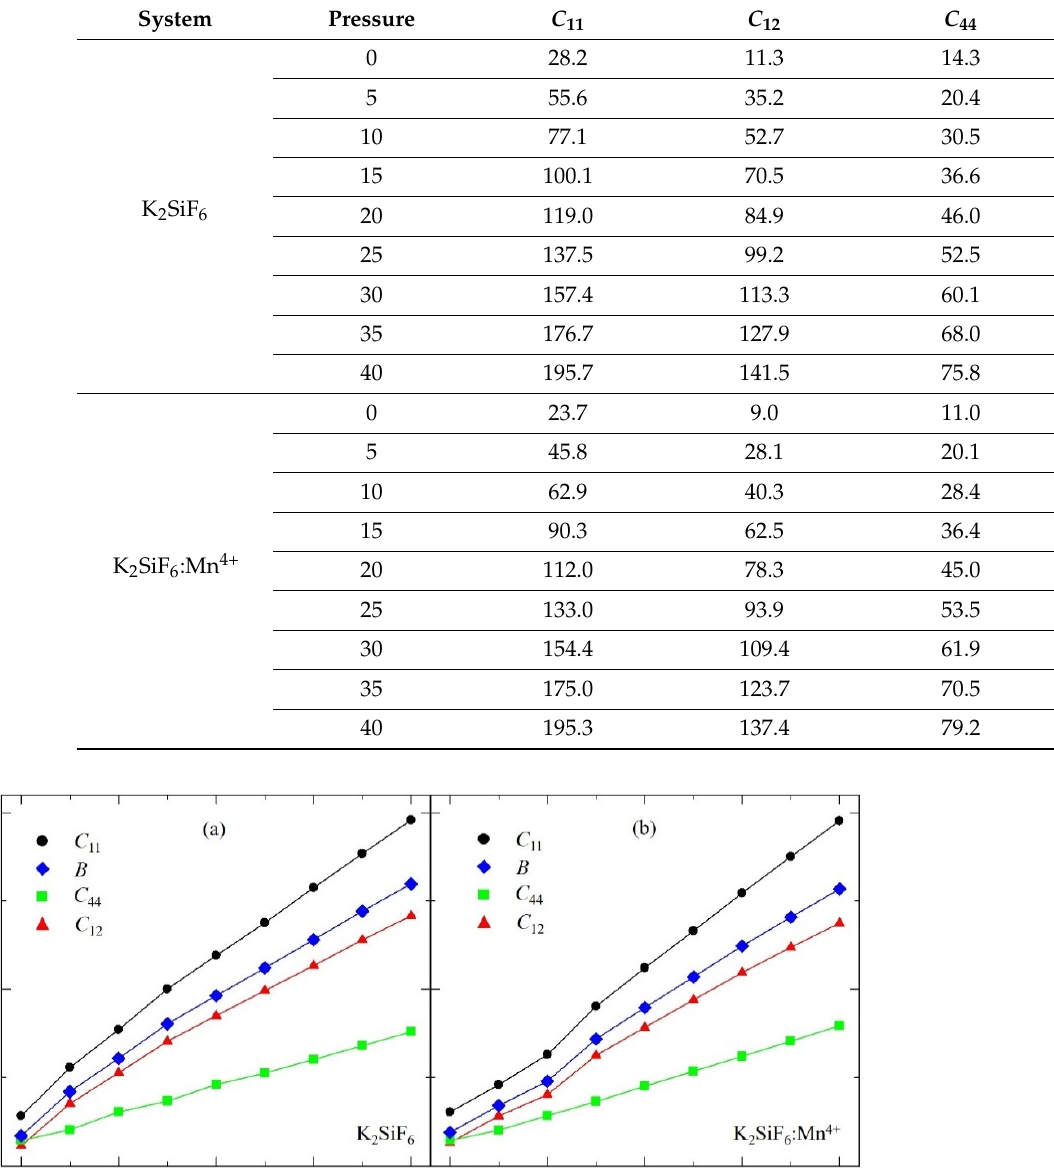
Table 2. Pressure dependence of the elastic constants C ij (all in GPa) for the non-doped and Mn 4+ - doped K 2 SiF 6 .